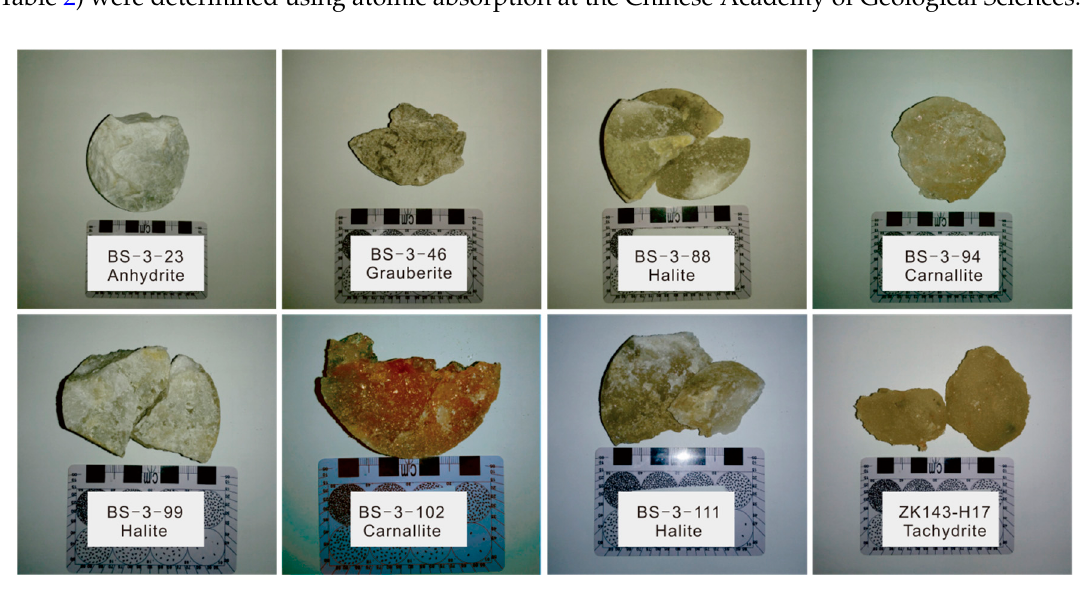
Figure 2. Photographs of the mineral samples from the Mboukoumassi deposit, Kouilou Province, Congo. Table 1. Sample location, lithology, and mineral descriptions; Mboukoumassi deposit, Kouilou Province, Congo.